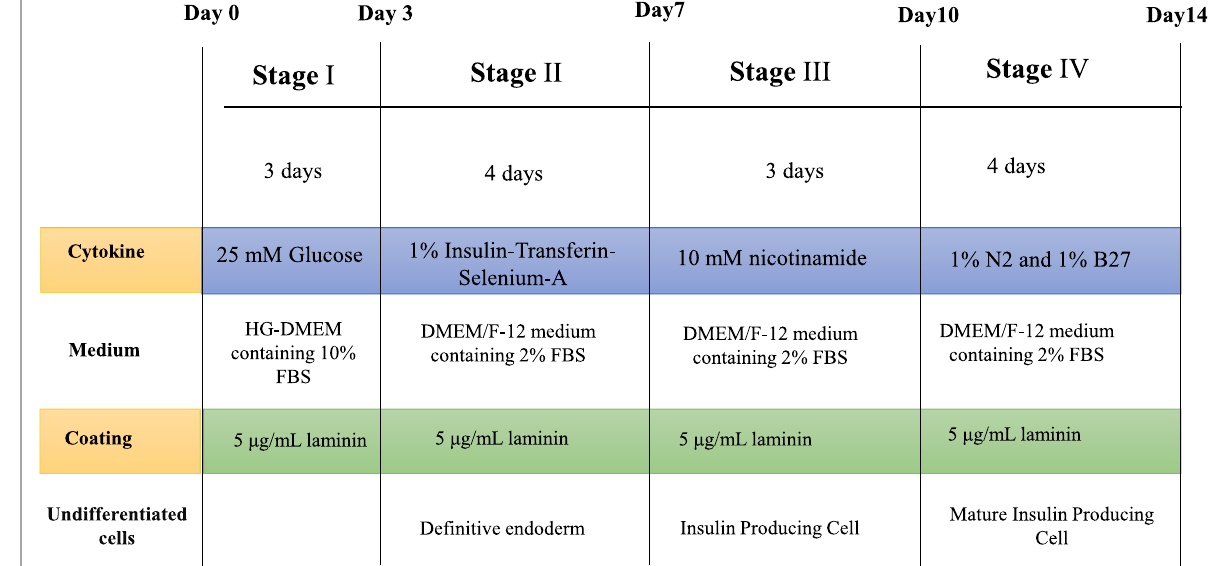
Fig. 1 Schematic diagram outlining the differentiation protocol for dental derived stem cells (hDPSCs & hPDLSCs) into insulin‑producing cells (IPC). Durations and required factors for each differentiation step are